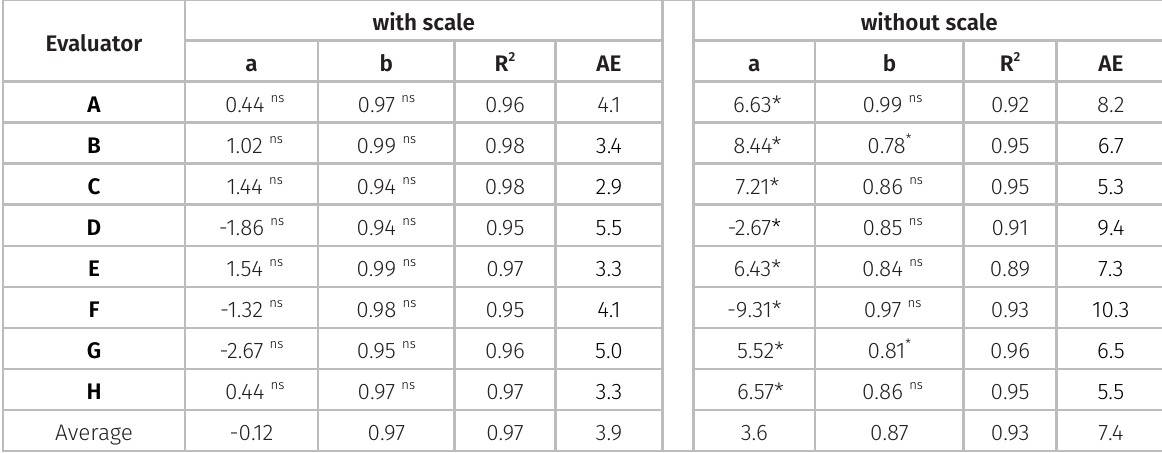
* - situations in which the null hypothesis ( a = 0 or b = 1) was rejected in the t-test at a significance level of 5%. ns – no significant